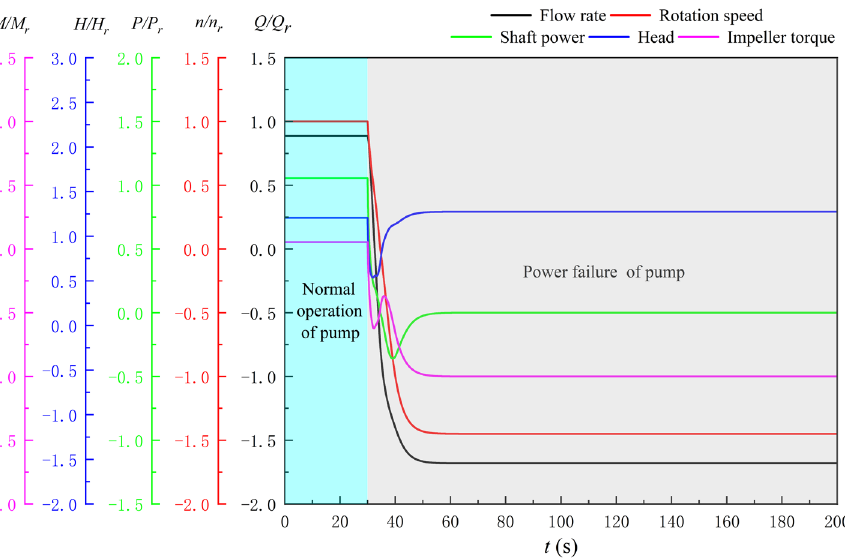
Figure 11. MBV and RS of the LAPS after a power failure in the case of the GOOC.